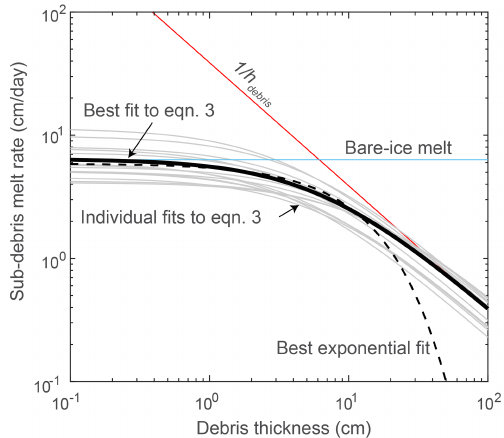
Figure 3. Compilation of curve fits to data from 15 melt rate vs. debris thickness studies (Østrem, 1959; Loomis, 1970; Khan, 1989; Mattson et al., 1993; Lundstrom, 1993; Kayastha et al., 2000; Lukas et al., 2005; Mihalcea et al., 2006; Nicolson and Benn, 2006; Hagg et al., 2008; Reid and Brock, 2010; Wang et al., 2011; Fyffe, 2012; Brook et al., 2013; Anderson, 2014) (mean h ∗ is 0 . 066 ± 0 . 029m (1 σ ), and ranges from 0.03 to 0.13m). These curve fits are used to determine the parameter ranges in Table 1 for h ∗ . The best exponen- tial fit is the mean of all the exponential curve fits; using sub-debris − h debris − 1 , b = 12 . melt = ae b a = 5 . 89cmday